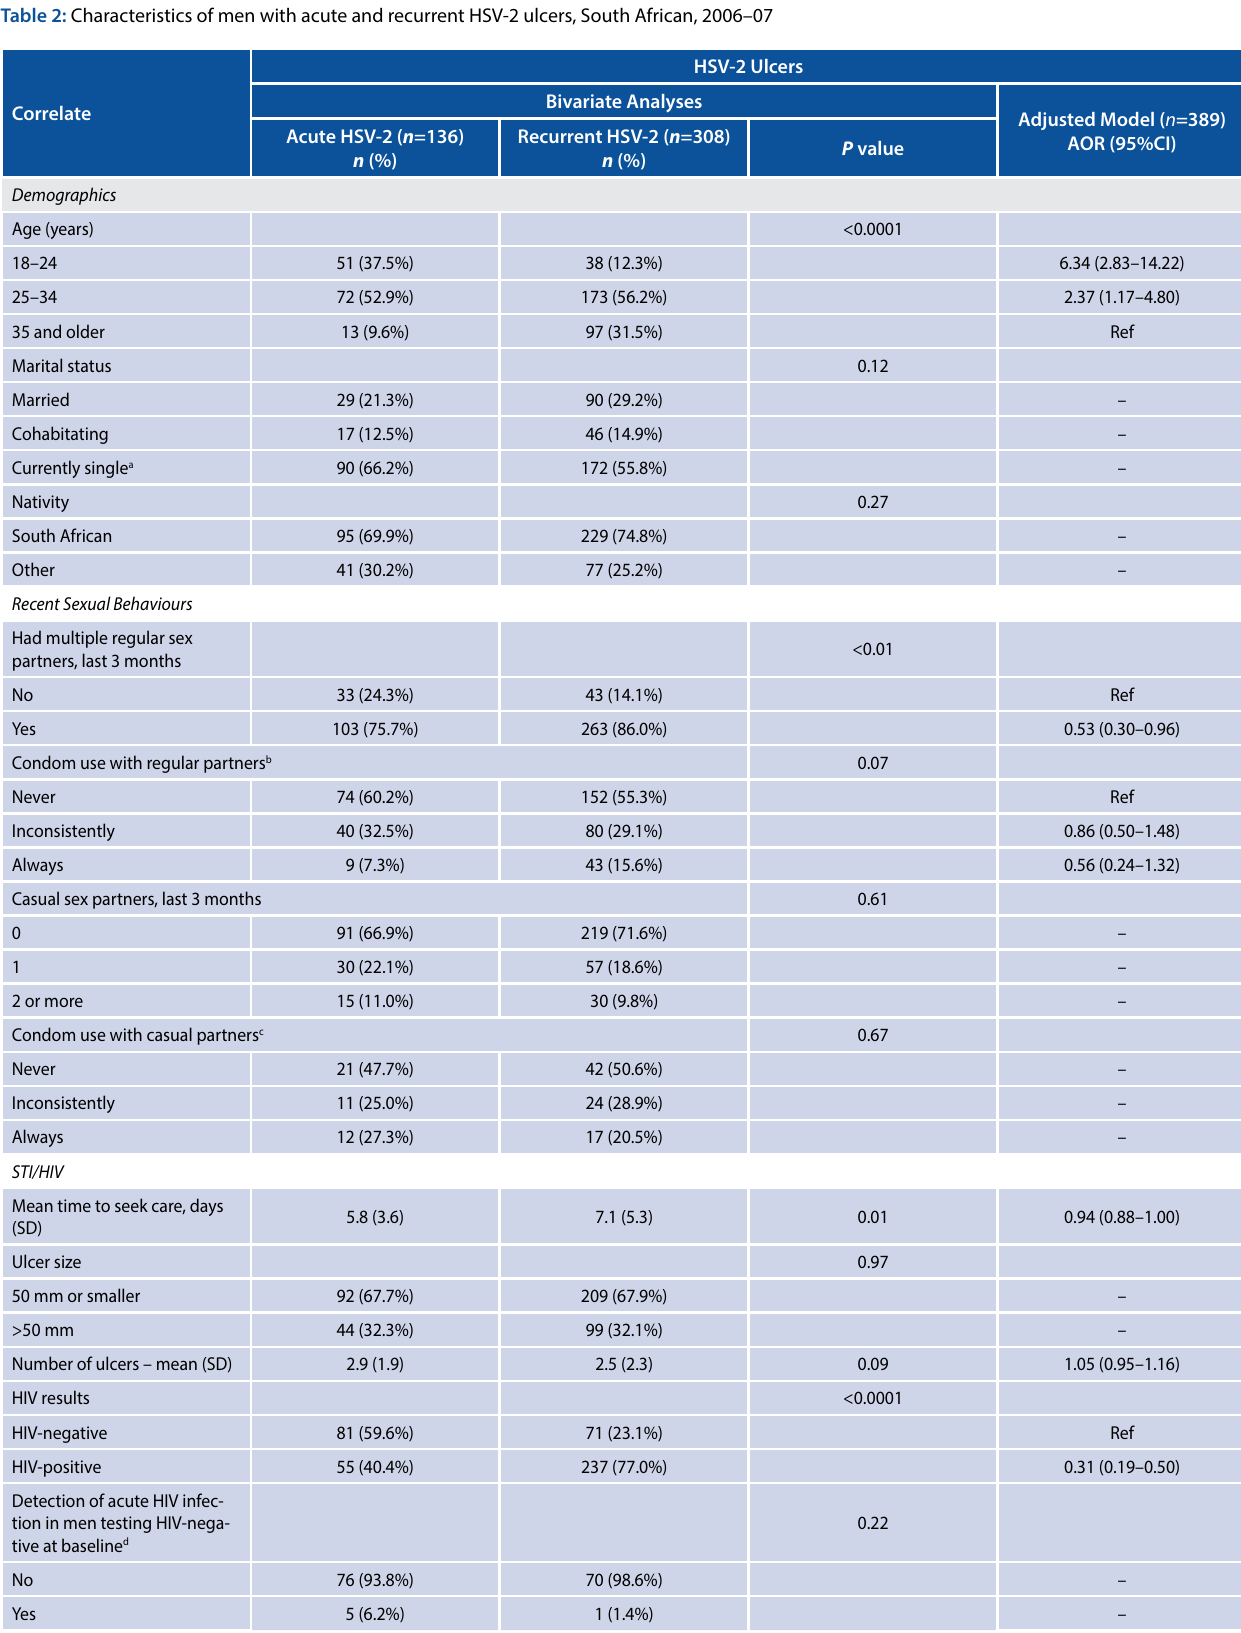
Table 2: Characteristics of men with acute and recurrent HSV-2 ulcers, South African,